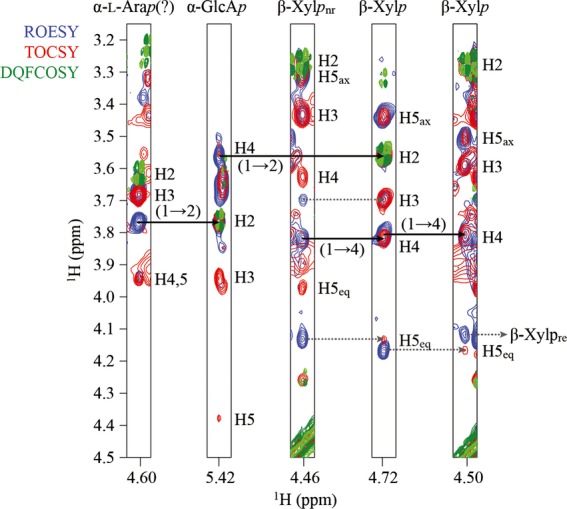
Nuclear magnetic resonance (NMR) analysis of PUX5. H-1 strip plots from 2D 1H-1H TOCSY (red) ROESY (blue) and DQFCOSY (green) spectra, showing the nuclear Overhauser effect (NOE) connectivity arising from the pentose-α-1,2-GlcpA-α-1,2-Xylp and β-Xylp-β-1,4-Xylp glycosidic linkages.